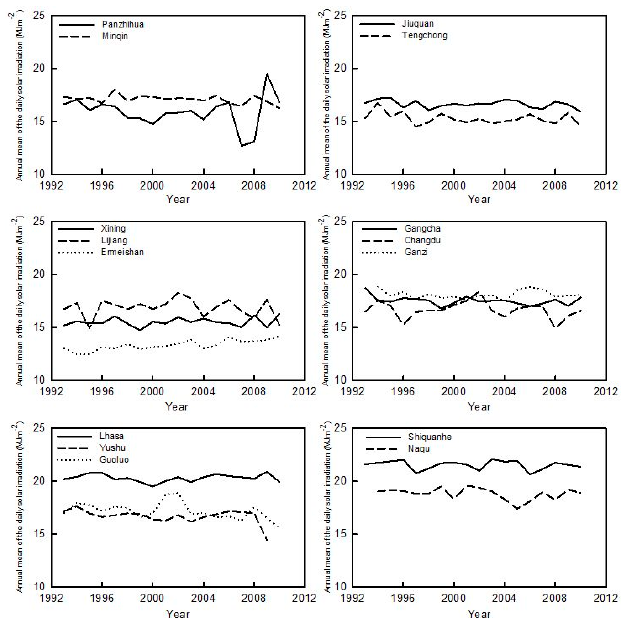
Figure 1. Variation of annual mean of daily solar irradiation on the Tibetan Plateau and its surrounding regions.